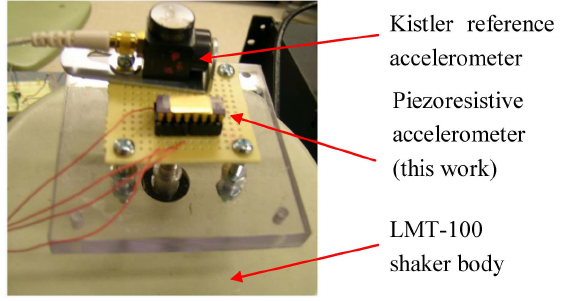
Figure 11. Test board on which the DUT and the reference accelerometer are